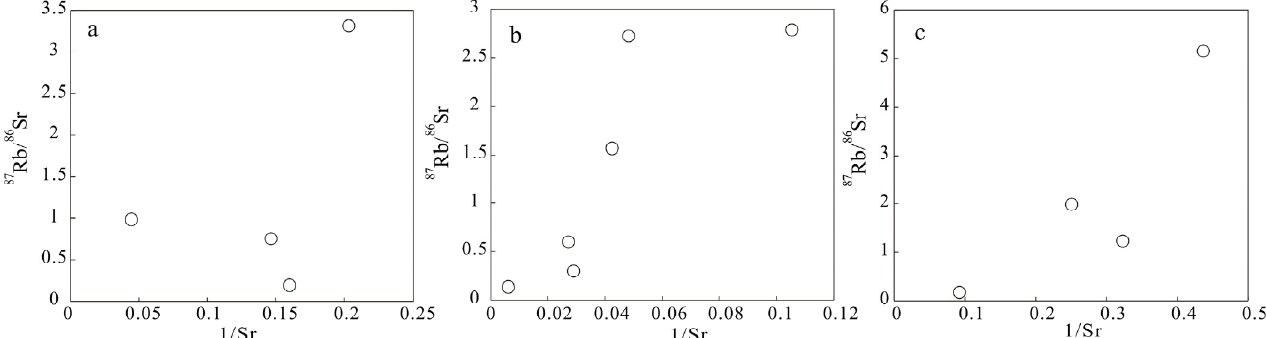
Figure 9. ( 87 Sr/ 86 Sr)–(1/Sr) diagrams for the pyrites from banded silicification ( a ), diorite porphyrite ( b ), and quartz veins ( c ) (modified after Li et al., 2002 [76]).